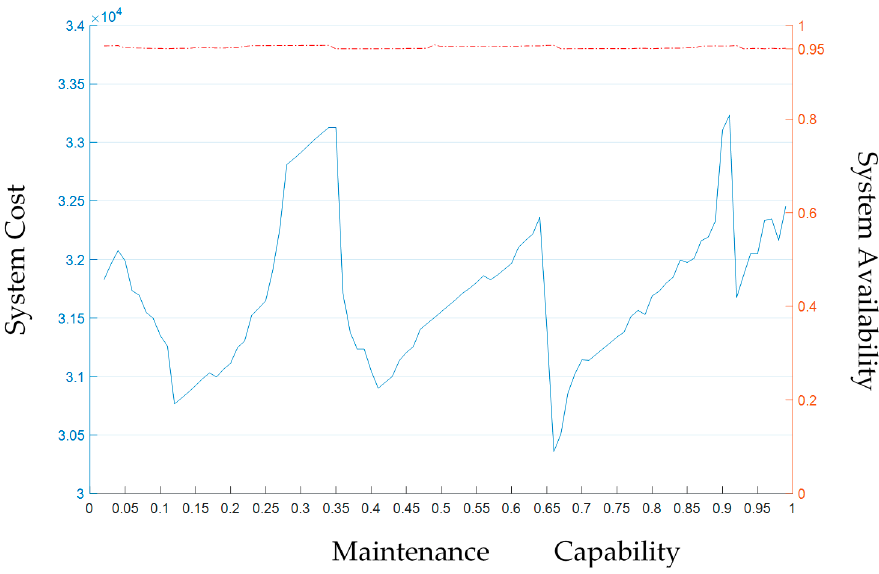
Figure 5. Joint iterative optimization method.